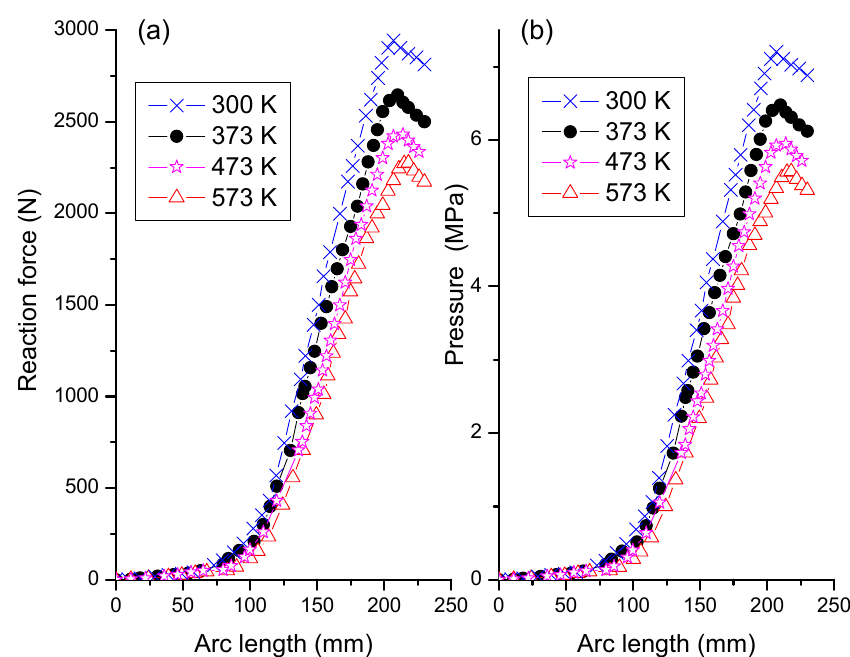
Figure 9. The relationships between the maximum reaction force: ( a ) pressure, and ( b ) arc length, at different temperatures obtained from cloud maps as shown in Figure 7.